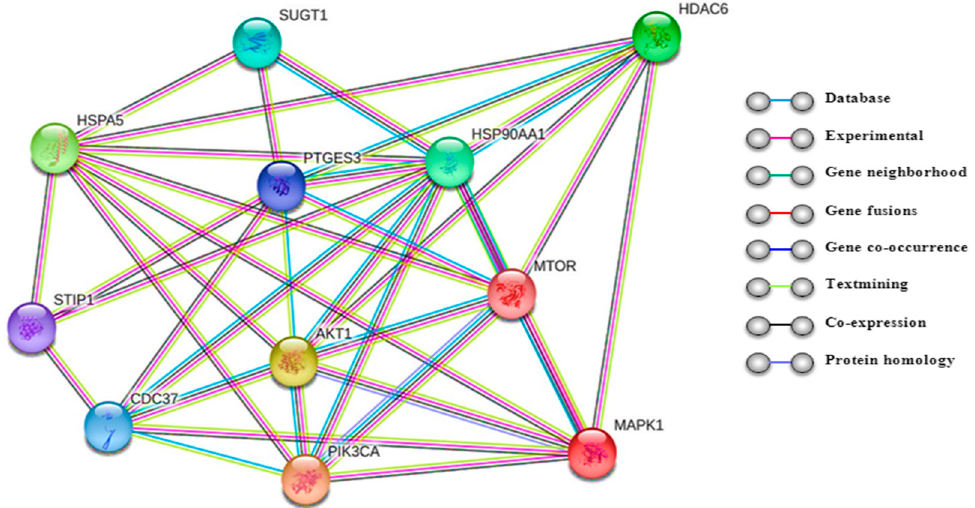
Figure 1. HDAC6 directs a variety of cellular processes that are important for cancer pathogenesis. Genetic interaction network using String (available online: https://string ‐ db.org, accessed on 5 July 2018) that evaluates pathways and visualizes the connection among target genes according to the